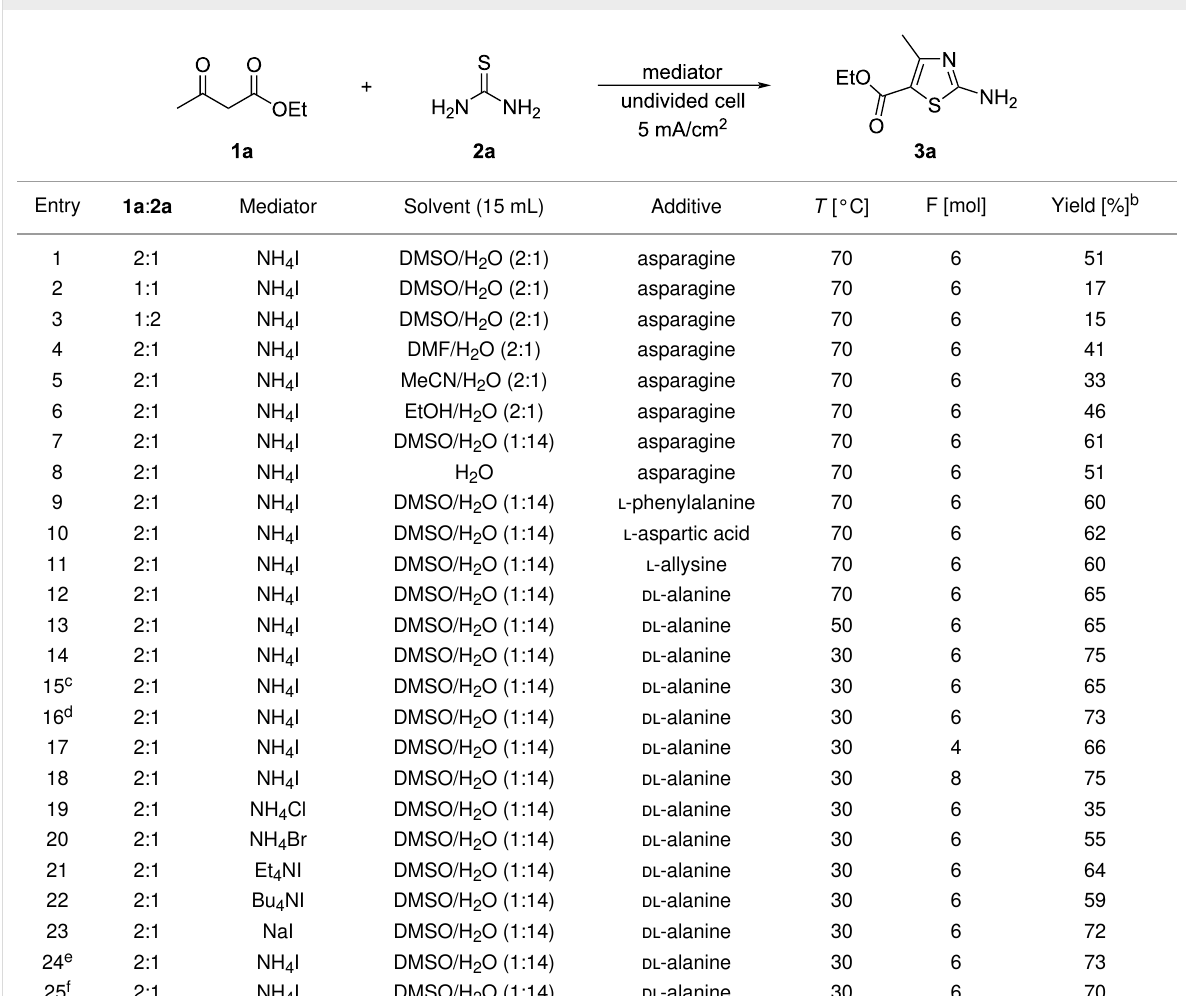
Table 1: Optimization of the reaction conditions a